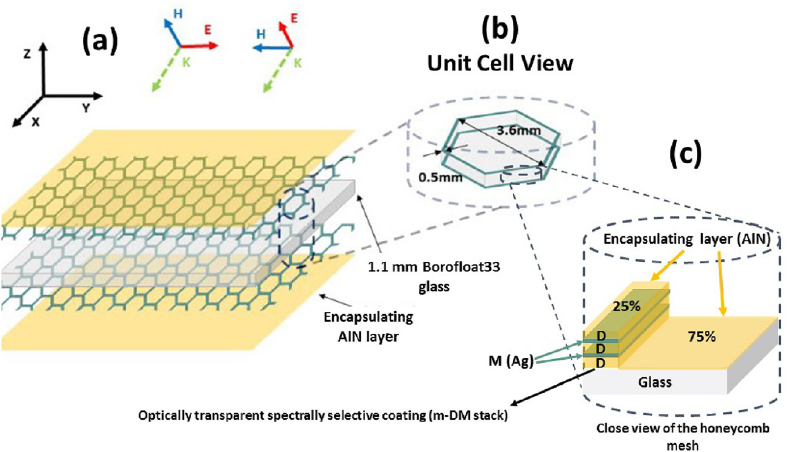
Figure 1: (a) Meta-glass: a symmetrically layered structure made of identical metasurfaces on both faces of the glass substrate. (b) Unit cell view of the meta- glass comprising aligned honeycomb meshesonbothsides.(c)Honeycombmesh made of a cascading multilayered dielectric-metal (m-DM) spectrally selective coating.